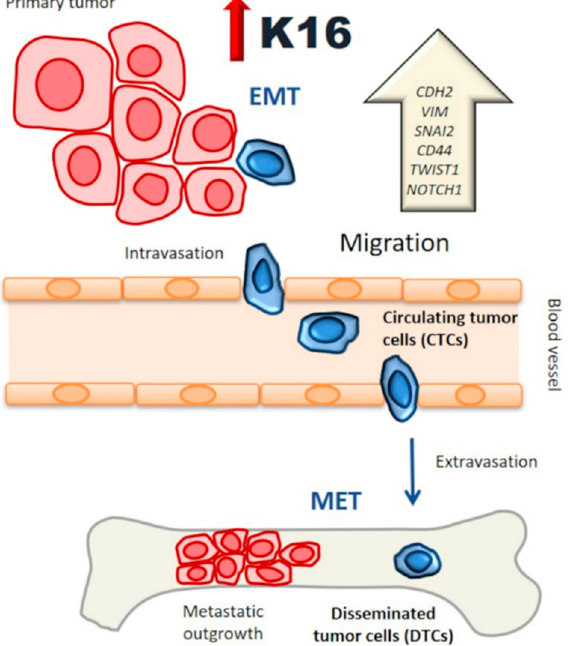
Figure 7. K16 functional model: K16 is involved in a functional transition of polarized epithelial cells to motile by promoting EMT regulator genes while preserving the epithelial phenotype, enhancing the migration of tumor cells to access the bloodstream and survive as a circulating tumor cell (CTCs). These tumor cells have a semi-mesenchymal phenotype with a high capacity to generate metastasis.